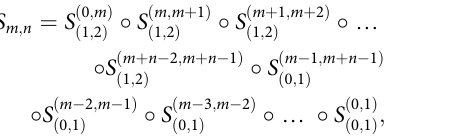
where i j if g d (cid:2) 1 are the eigenvectors of H , ordered so that E i ≤ E i +1 i ¼ 0 for all i (for the case of equal energies E i = E i +1 we must make an additional stability assumption to ensure that p i = p i +1 ).